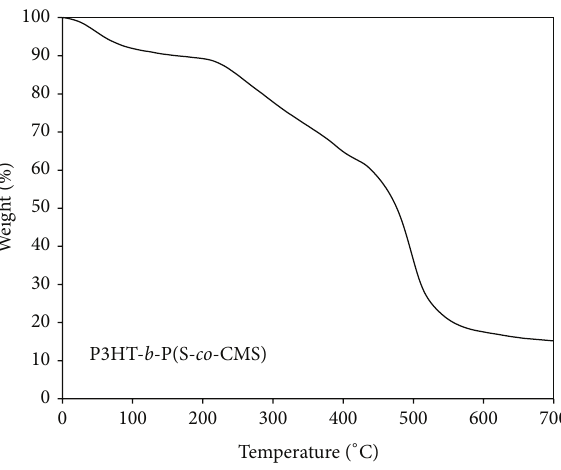
Figure 6: TGA thermogram of the P3HT- b -P(S- co